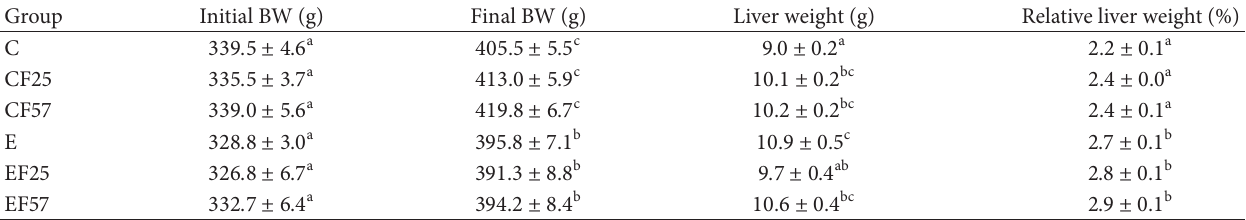
Table 3: Effects of fish oil on the initial body weight (BW), final BW, liver weight, and relative liver weight in rats under chronic ethanol feeding 1,2,3 .